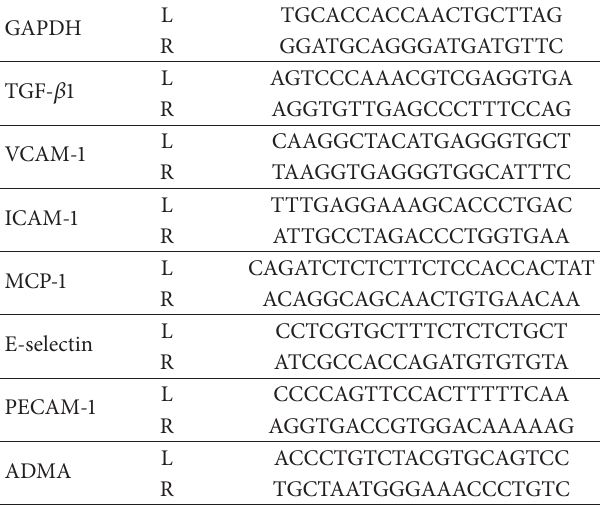
Table 1: RT-PCR primers for rat thoracic